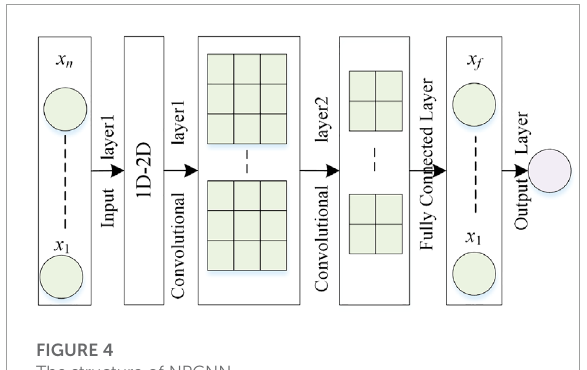
FIGURE 4 The structure of